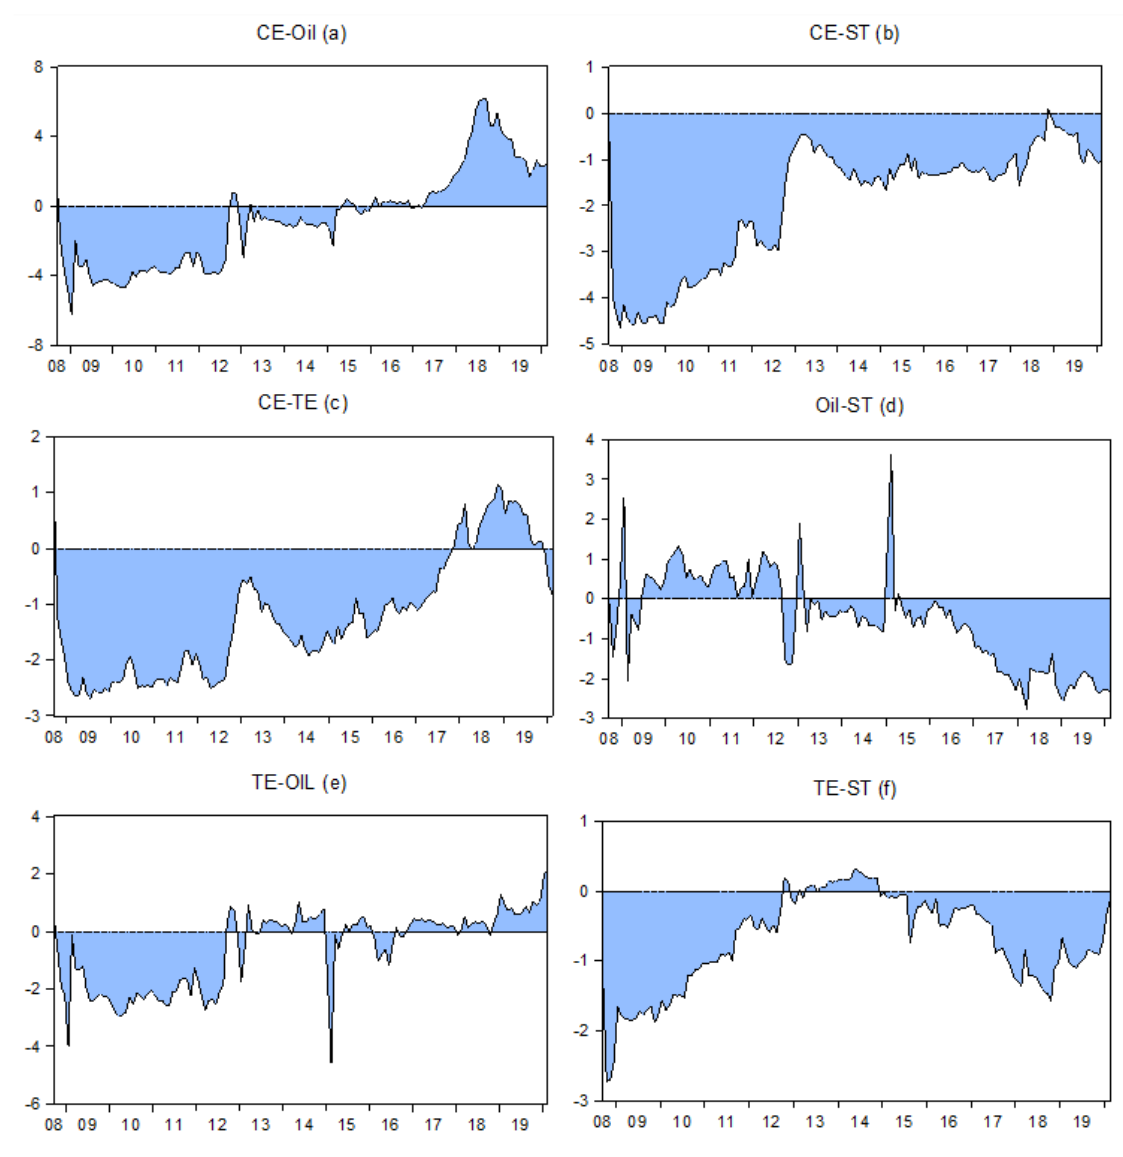
Figure 6. Net pairwise spillover among clean energy (CE), S&P 500 (ST), technology (TE), and crude oil (WTI) series. Note: Positive values indicate transmitting spillover while negative values show receivers of spillover. The x -axis indicates the